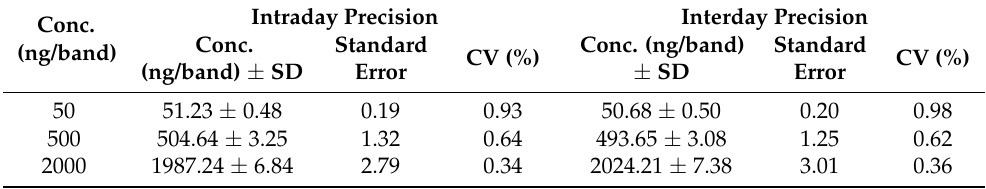
Table 3. Evaluation of precision of thymol for the greener normal-phase HPTLC method a . Conc.